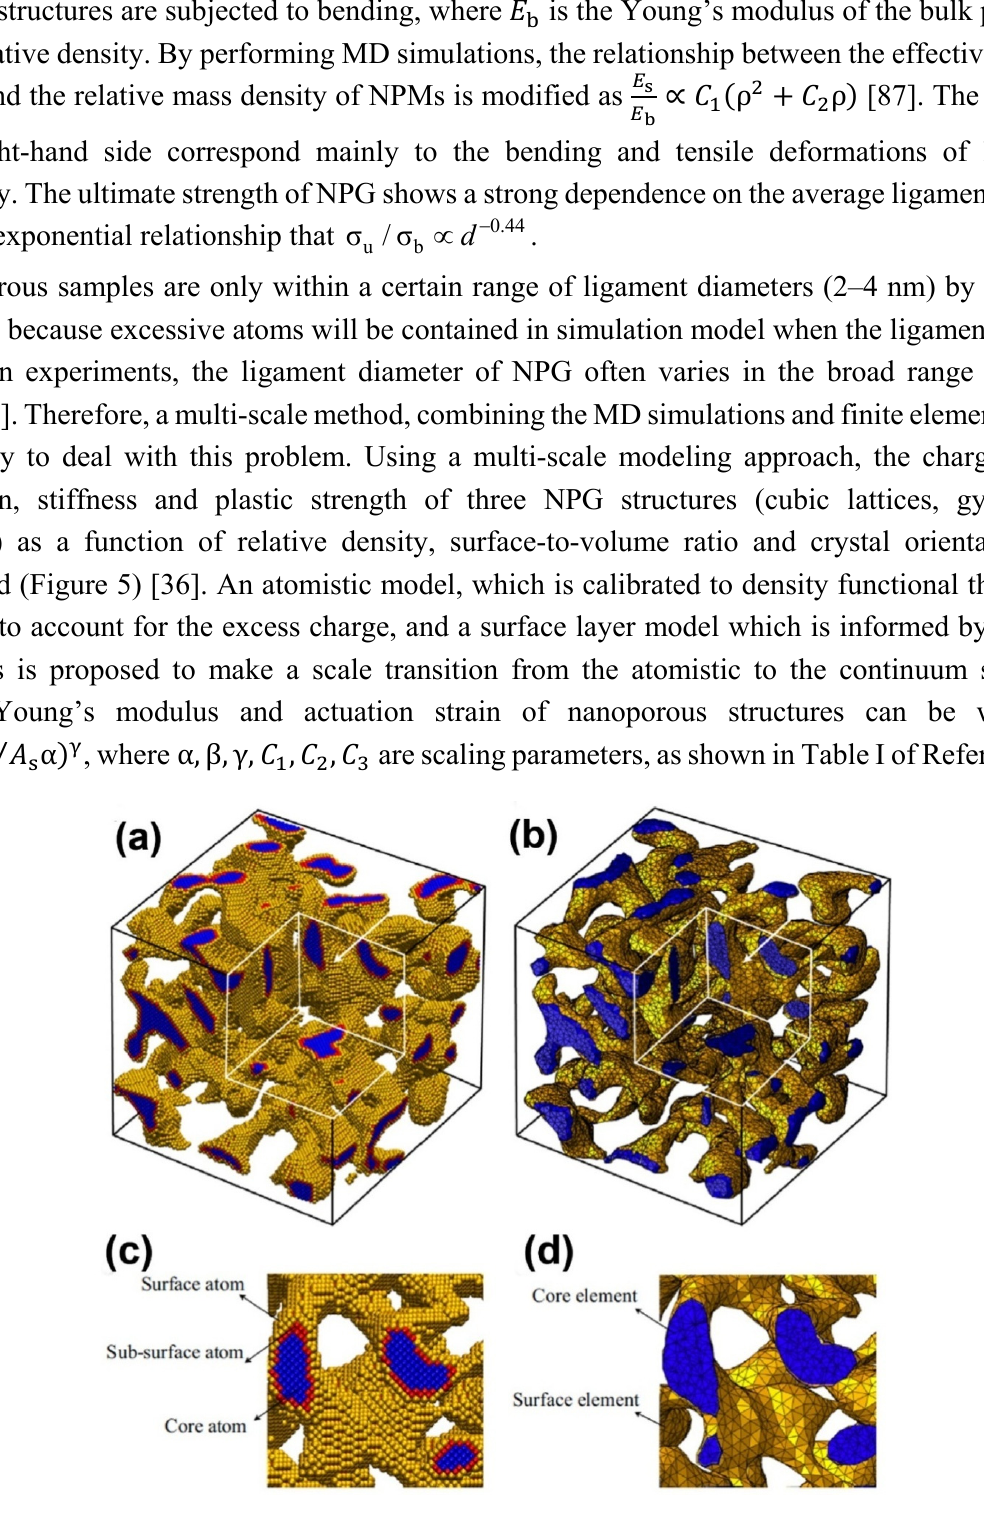
Figure 5. Multi-scale model of nanoporous gold: ( a ) atomistic model and ( b ) continuum model; ( c ) and ( d ) are the enlarged views of a cross-section of ( a ) and ( b ), respectively. Reproduced with permission from Reference [36]. (Copyright Elsevier